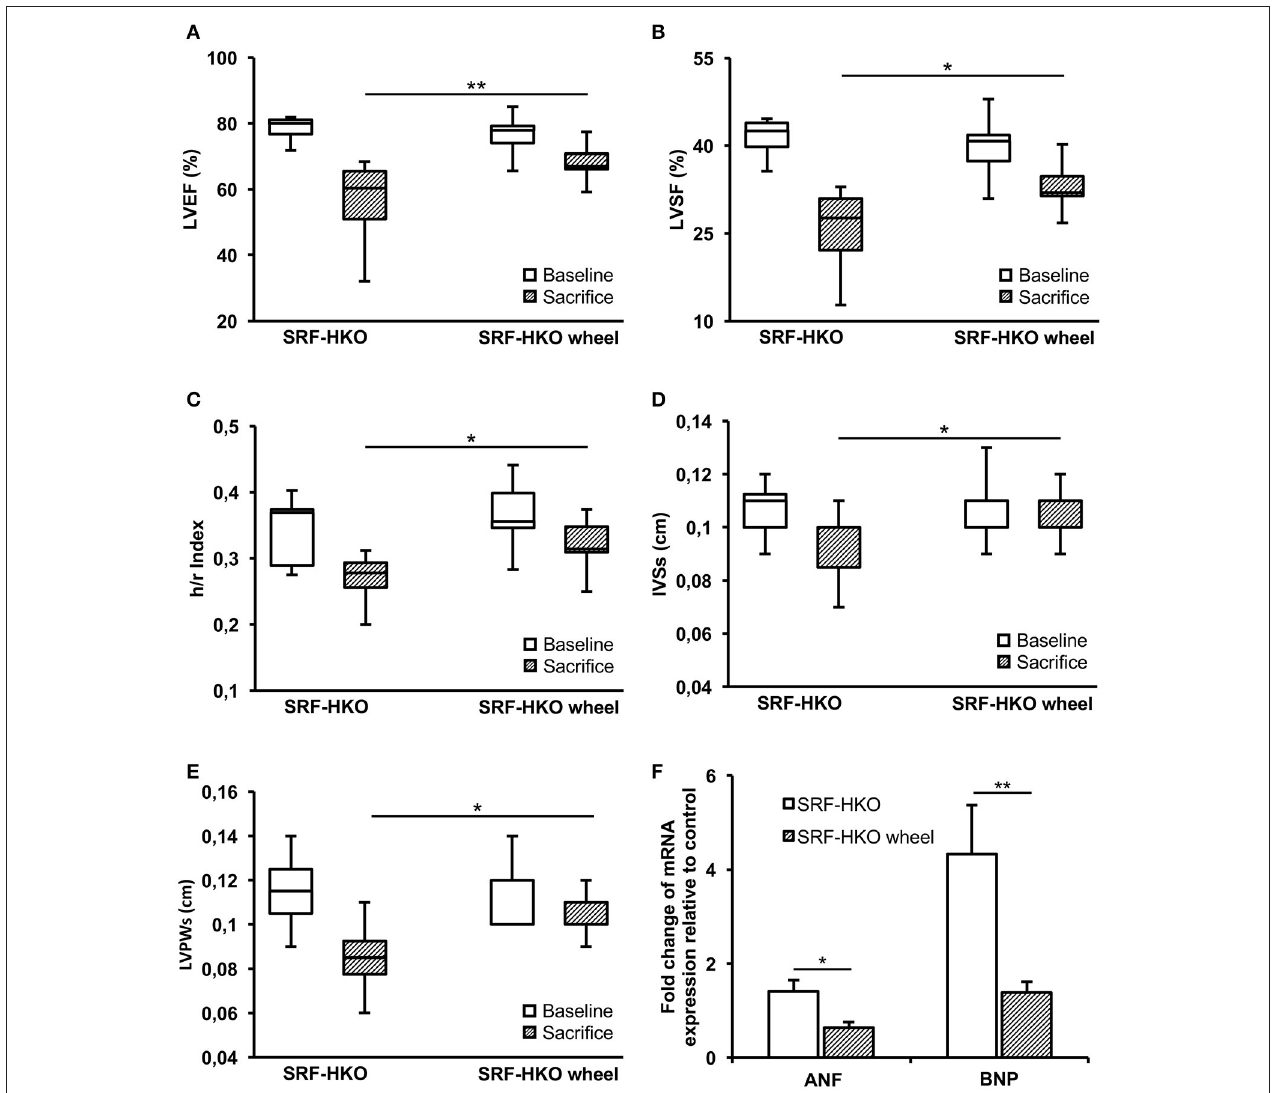
FIGURE 1 | Left ventricle function and structure assessments by echocardiography (A–E) and real-time PCR (F) in SRF-HKO and SRF-HKO wheel mice. (A–E) Evolution of left ventricle ejection fraction (LVEF), left ventricle shortening fraction (LVSF), thickness/radius ratio (h/r), end-systolic inter ventricular septum thickness (IVSs) and end-systolic left ventricle posterior wall thickness (LVPWs) before (baseline) and 40 days (sacrifice) after tamoxifen injections in SRF-HKO ( n = 8) and SRF-HKO wheel ( n = 9) mice. (F) Relative quantification by real-time PCR of Atrial Natriuretic Factor (ANF) and Brain Natriuretic Peptide (BNP) mRNA levels in myocardial tissue. Results are presented in-terms of a fold change to control after normalizing with Hmbs mRNA. The control mice value is set at 1.0. Results are expressed as mean values ± SEM. * p < 0.05; ** p <